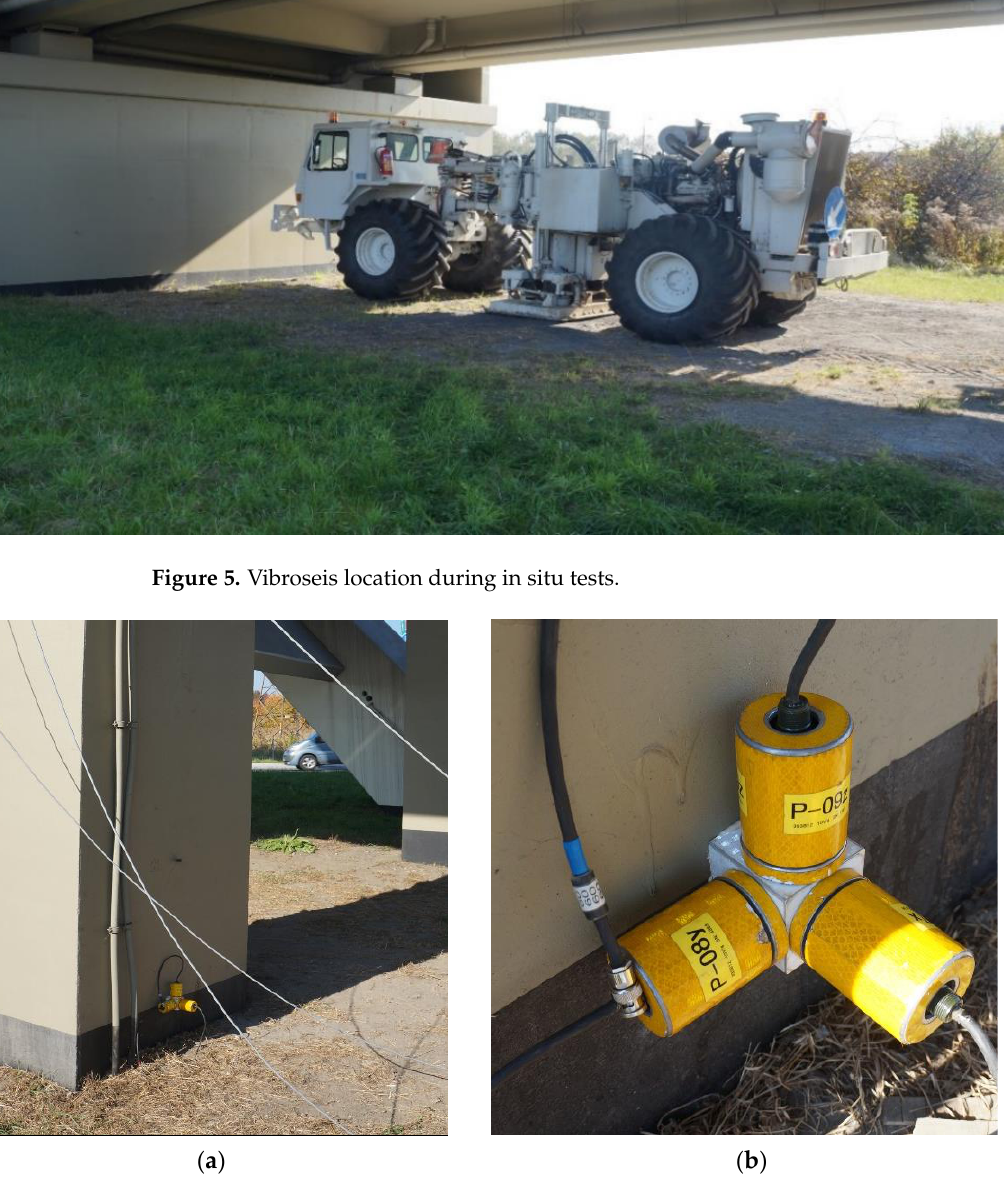
Figure 6. ( a ) The location on the second pier; ( b ) the details of accelerometers mounting.